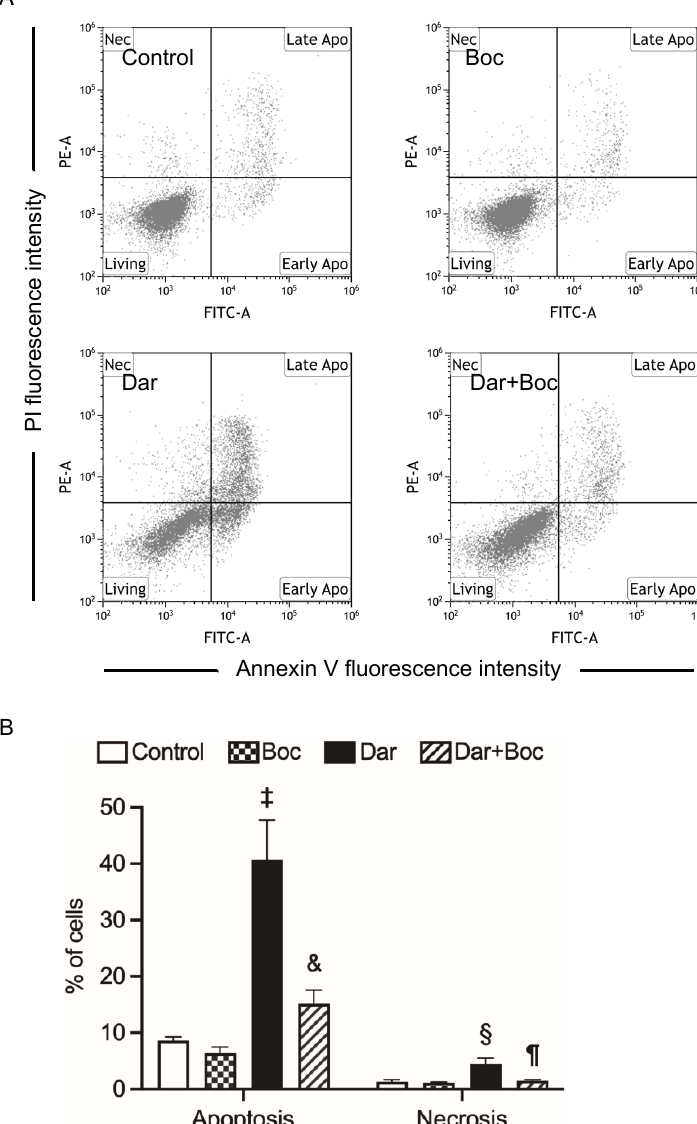
Figure 4. Suppression of darinaparsin-mediated cell death by Boc-D-FMK in NB4 cells. After treat- ment for 24 h with 1 µ M darinaparsin in the presence or absence of 10 µ M Boc-D-FMK, a pancaspase inhibitor, cells were stained with annexin V-FITC and PI and analyzed by flow cytometry as described in the legend of Figure 2. Representative flow cytometry dot plots from three independent experi- ments ( A ), and the quantification in the percentages of apoptotic and necrotic cells ( B ) are shown. Results are shown as the means ± SD from more than three independent experiments. §, p < 0.001; ‡, p < 0.0001 vs. control; ¶, p < 0.01; &, p < 0.001 vs. darinaparsin. Dar, darinaparsin; Boc,